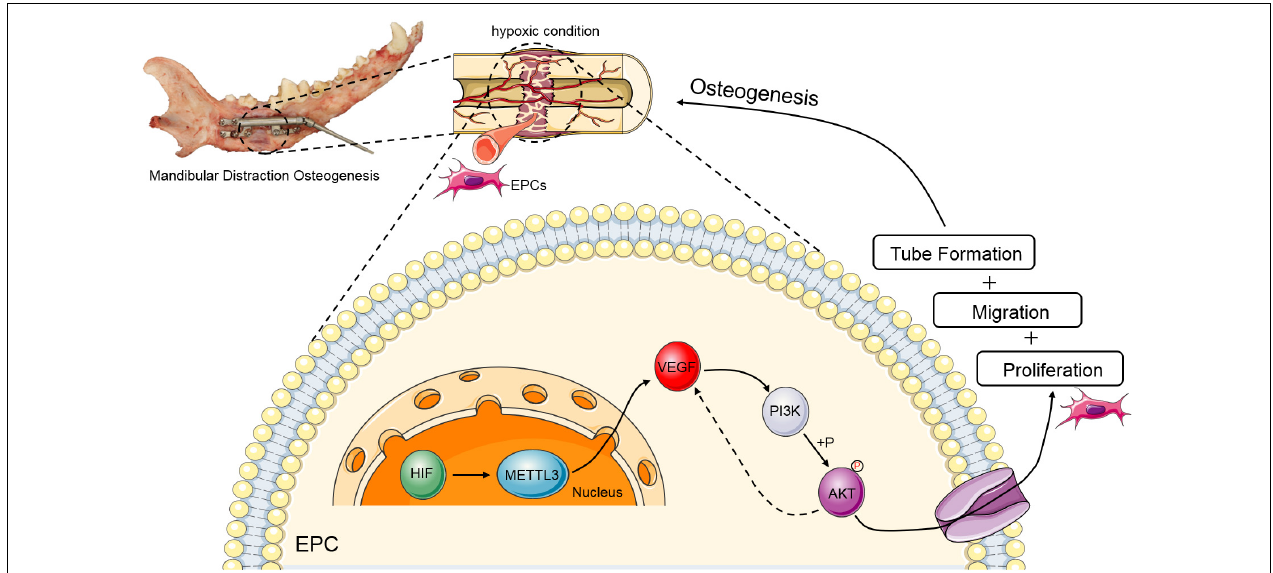
FIGURE 6 | Schematic overview of the mechanisms whereby METTL3 controls PI3K/AKT signaling activity in the context of DO-related EPC angiogenesis. During DO-related tissue regeneration, the DO gap is a hypoxic environment. Upon upregulation, METTL3 can target VEGF to gradually increase and positively regulate PI3K activity and AKT phosphorylation, with such PI3K/AKT signaling partially strengthening the expression of VEGF, ultimately promoting EPC proliferation, migration, and tube formation during DO and thereby facilitating osteogenesis.